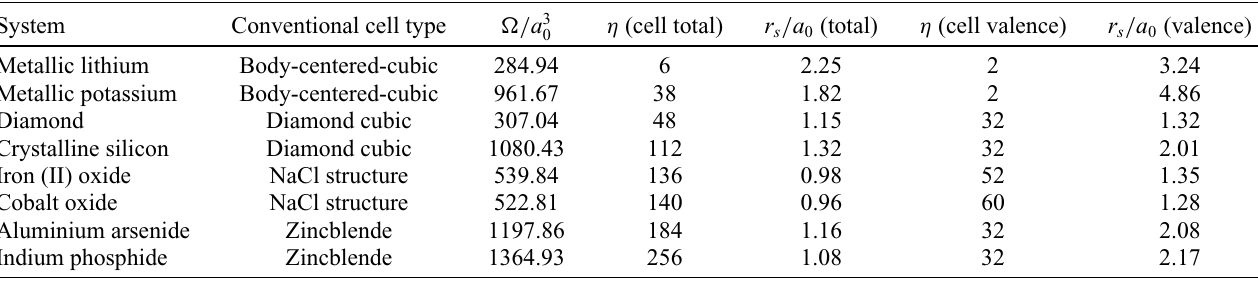
TABLE VI. Values of η , (cid:10) , and r s for a variety of common materials. Above, a 0 is the Bohr radius of the hydrogen atom and thus r s values are in units of Bohr and (cid:10) values are in units of Bohr 3 . Often one would want to perform a simulation with multiple unit cells in order to resolve correlations in between the units. Doing this would not change r s but it would increase η proportional to the number of unit cells included. The valence η and r s values correspond to simulations with core electrons removed. Doing this would require the use of pseudopotentials, which is beyond the scope of the current paper but likely an important next step. Note further that the unit-cell volumes tabulated here correspond to conventional unit cells, rather than primitive unit cells. Using primitive unit cells would necessitate adapting our approach to reciprocal spaces beyond the cubic Bravais lattices considered